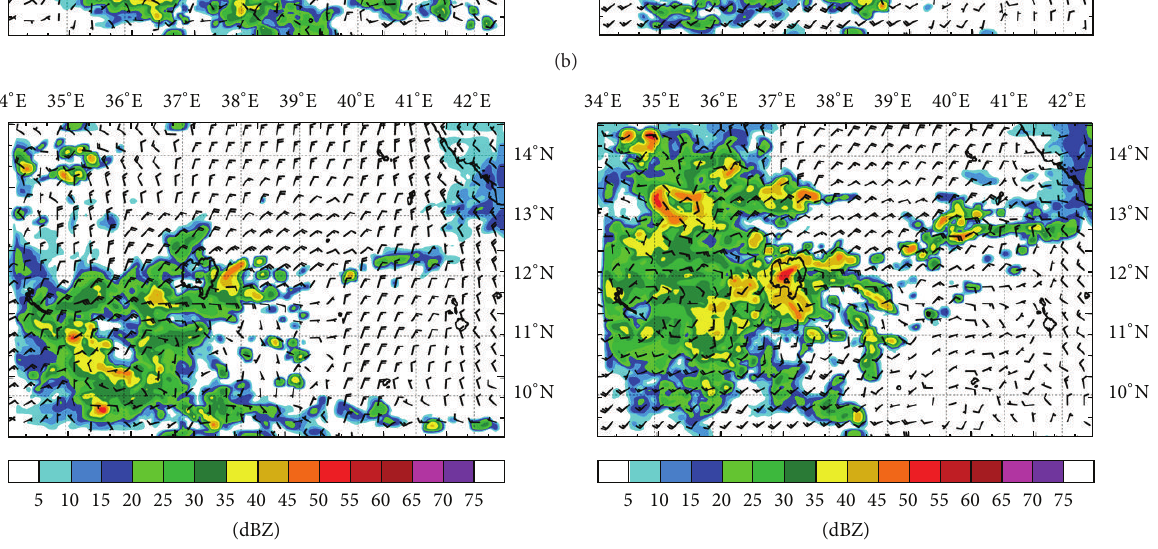
(2000 J/kg at 15:00). The diurnal peak of rainfall was 18:00– 24:00 LST, totaling ∼ 30 mm. A key finding is that the GFS model emphasizes the surface northerly winds observed at